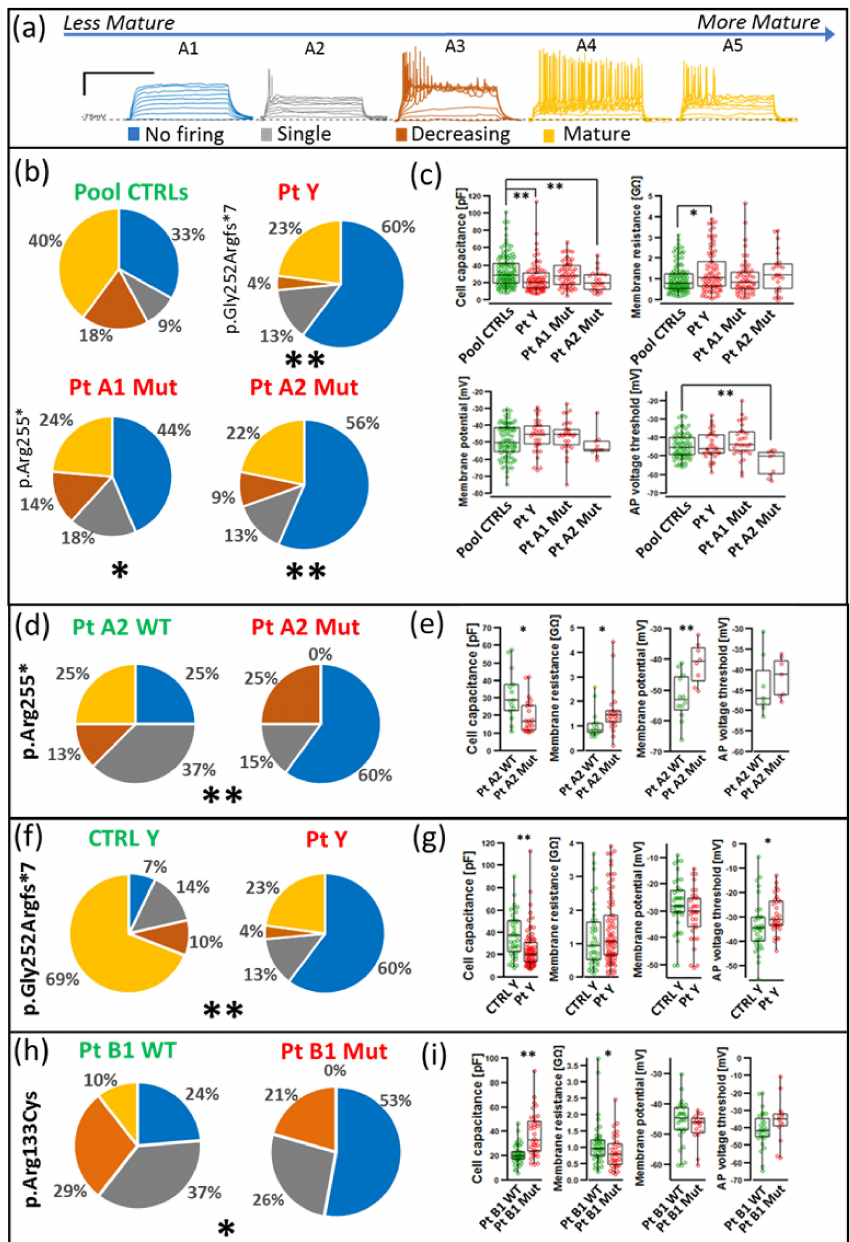
Figure 6. Differential alteration of firing and biophysical properties in neurons carrying different MECP2 mutations. ( a ) representative traces of four grades of firing classes using a code color from no firing (A1 blue) to single firing (A2 grey), decreasing firing (A3 orange) until increasingly mature neurons A4 and A5 (yellow) (calibration 1 s, 30 mV). ( b , d , f , h ): distribution according to the color code of the four firing classes in the neuronal populations from controls and RTT cases. The chi-square test was used to compare ( b ) mutated group versus controls pool (PtY p < 0.01, PtA1 Mut p = 0.02, PtA2 Mut p < 0.01), ( d ) the PtA2 mutated group versus its WT isogenic control ( p < 0.01), ( f ) the PtY mutated group versus the male control group ( p < 0.01), and ( h ) the PtB1 mutated group versus its isogenic WT control ( p < 0.01); ( c , e , g , i ): cell capacitance, membrane resistance, membrane potential, and action potential voltage threshold for the clones shown in ( b , d , f , h ). Cell capacitance, membrane resistance, membrane potential, and action potential voltage threshold data were not parametric and are reported as scatter plot on box-plots in ( c , e , g , i ) representing 90, 75, 50, 25, and 10% of the distribution. Data were compared using Mann–Whitney test. * p -value from 0.05 to 0.01, ** for p -value <